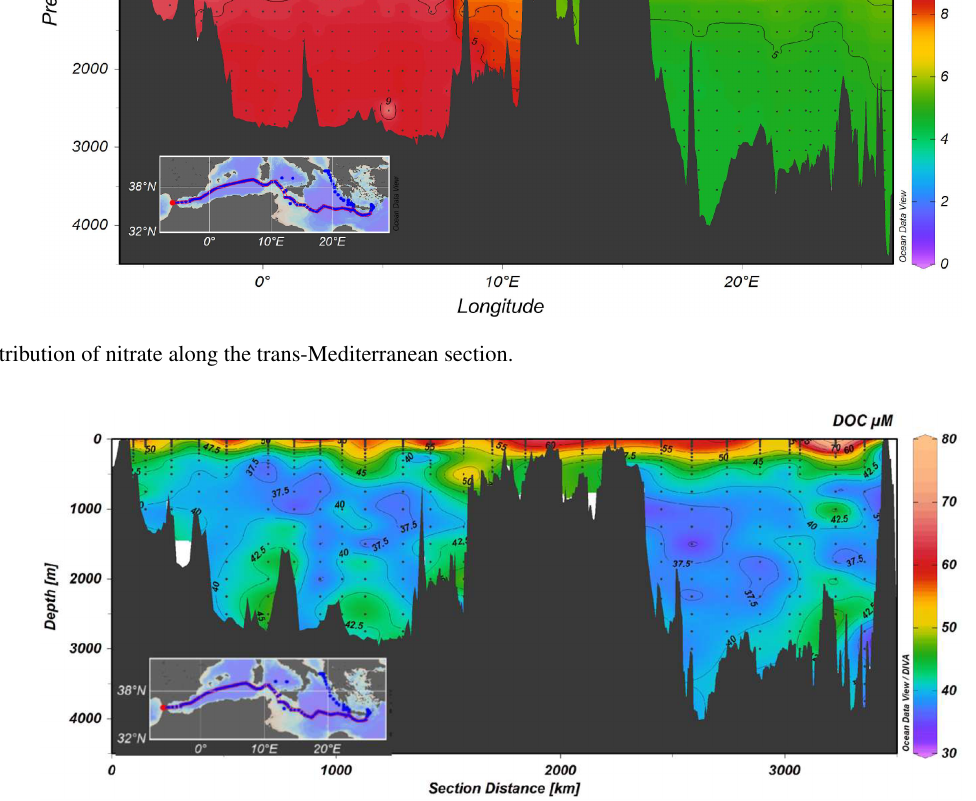
Figure 7. DOC vertical distribution along the trans-Mediterranean